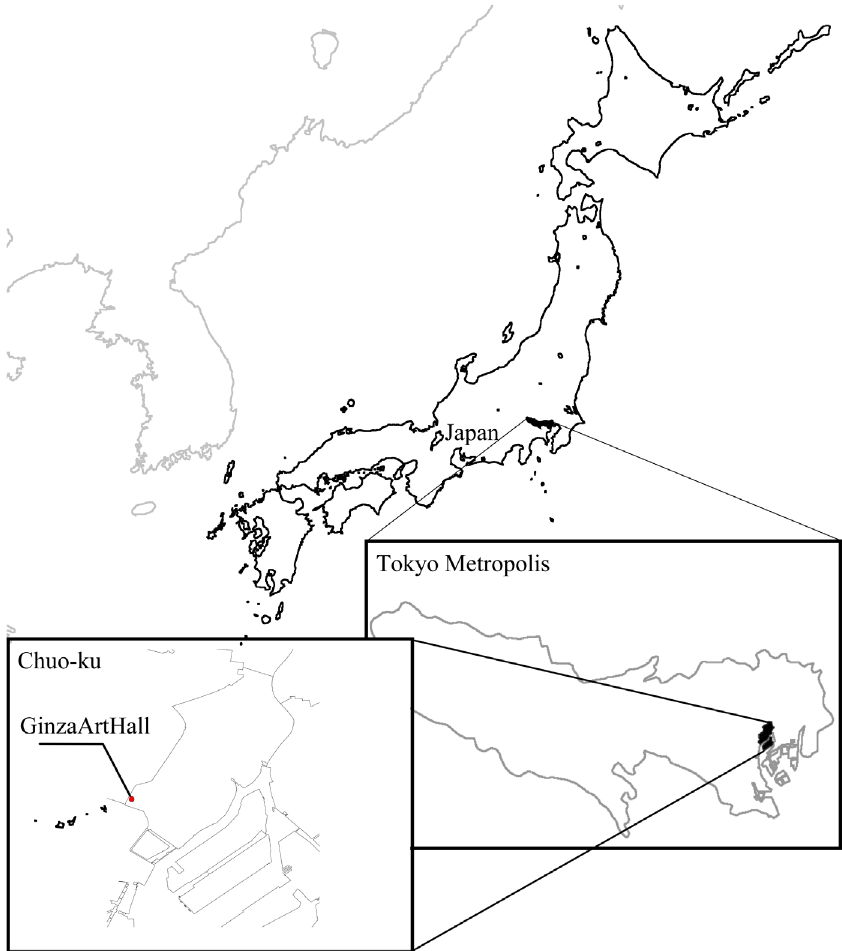
Figure 1. Location map of the experimental site.